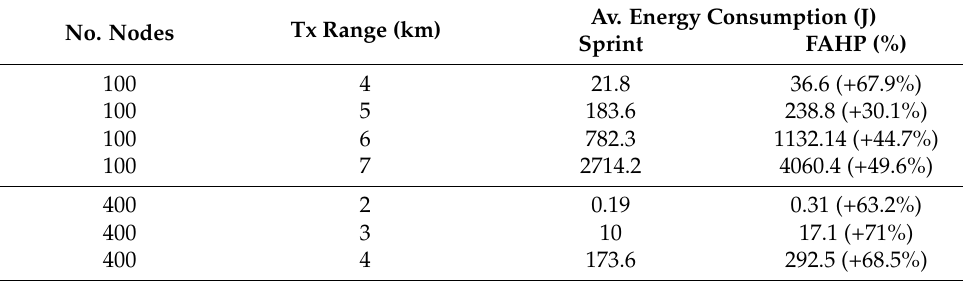
Table 13. Statistical comparison for average energy